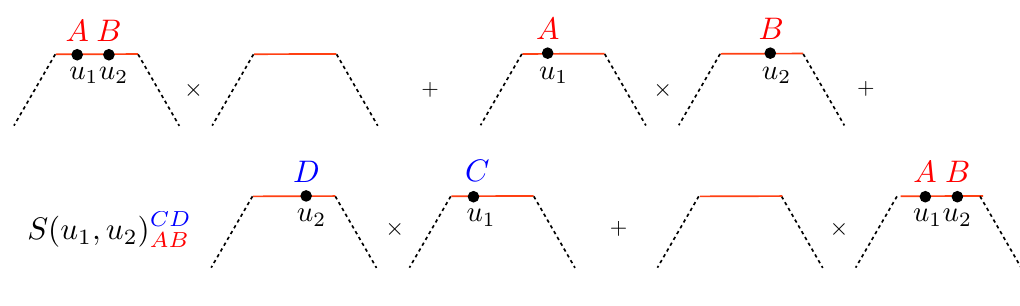
Figure 3. Splitting a two-particle state with indices. When the (cid:12)rst particle passes through the second particle, it gets multiplied by a S-matrix S ( u 1 ; u 2 ). The resulting state is a complicated object which includes a summation over indices ( C and D in the